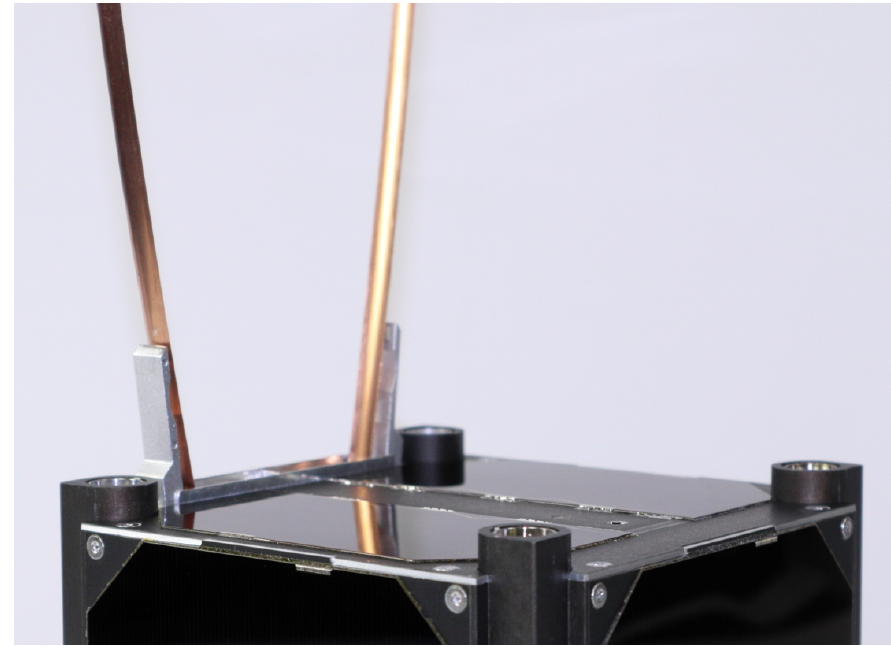
Figure 1. A photograph of the NanoFEEP thrusters integrated into the rails of the flight model of the UWE-4